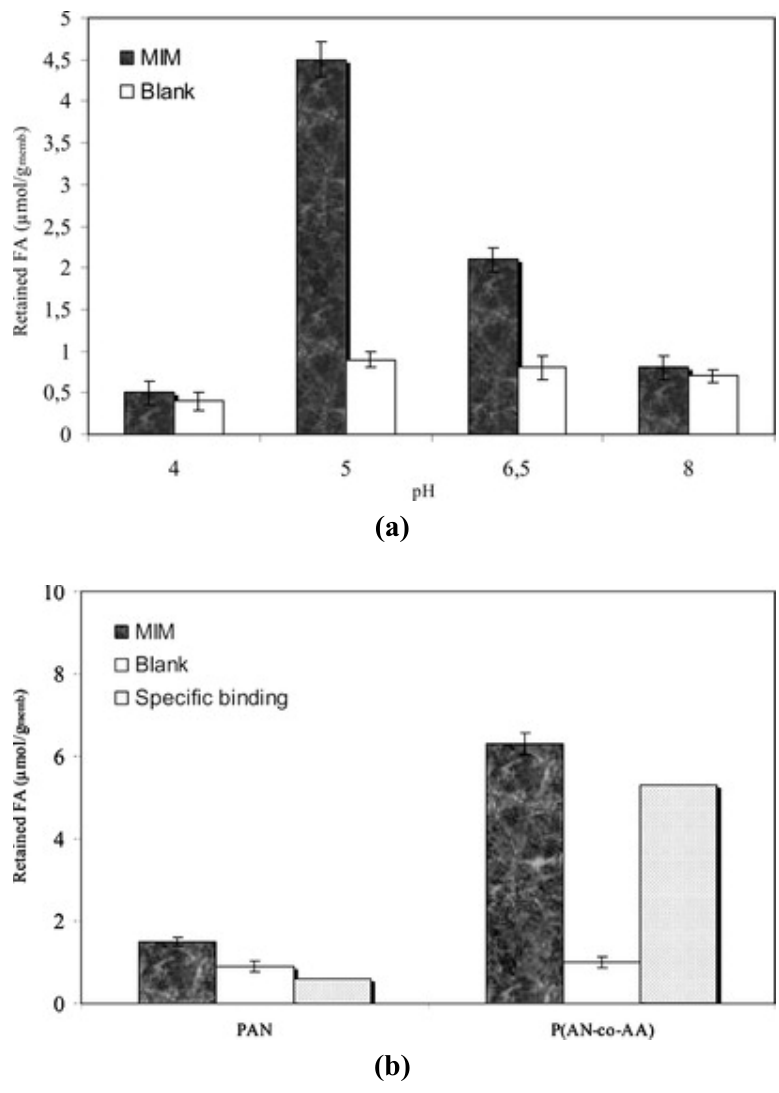
Figure 2. ( a ) pH effect on the binding capability of blank and MIM